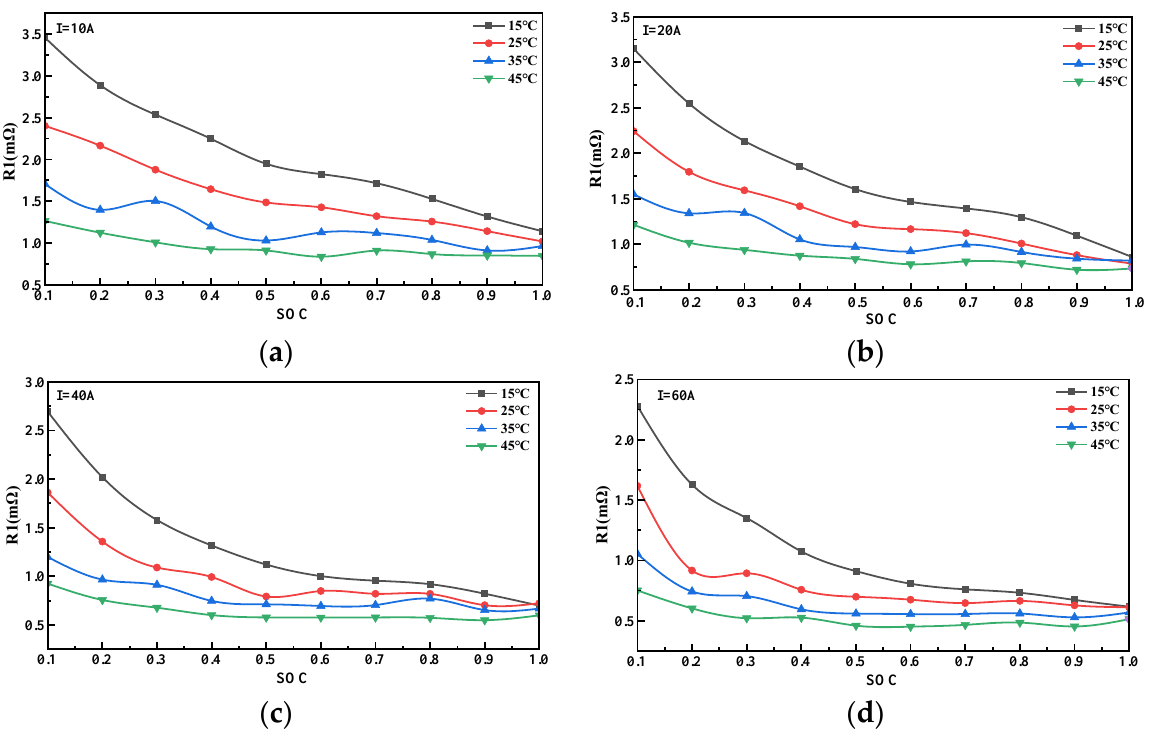
Figure 5. Identification of polarization resistance ( R 1 ) of battery: ( a ) The current of 10A, ( b ) the current of 20A, ( c ) the current of 40A, and ( d ) the current of 60A.